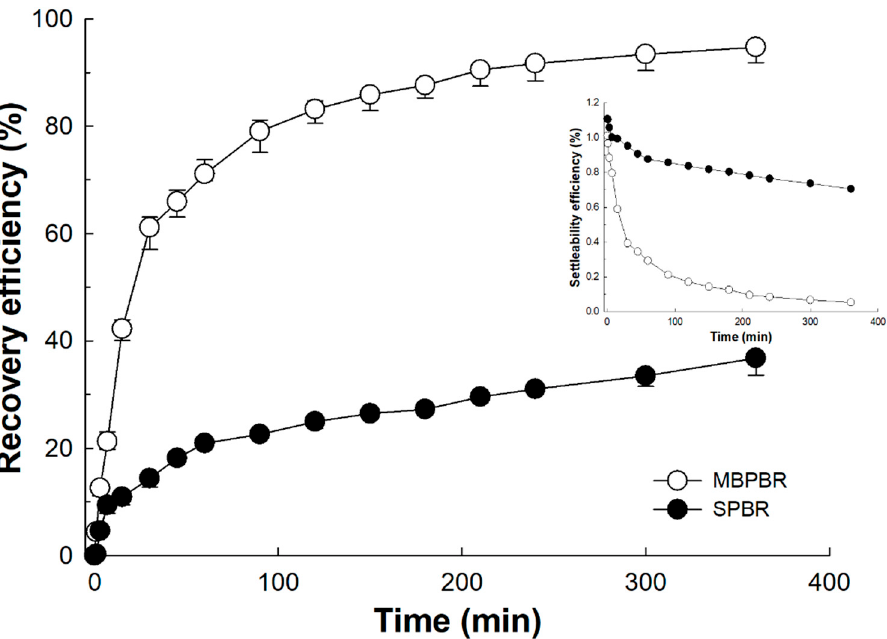
Figure 5. Settling effect of biomass from the photobioreactor with a moving bed (MBPBR) and the photobioreactor without a moving bed (SPBR). The recovery efficiency was calculated from the settleability efficiency with a continuous optical density of 490 nm for 6 h, as follows. Recovery efficiency (%) = ( O.D. t 0 − O.D. t )/ O.D. t 0 × 100, where O.D. t is the optical density at time t and O.D. t 0 is